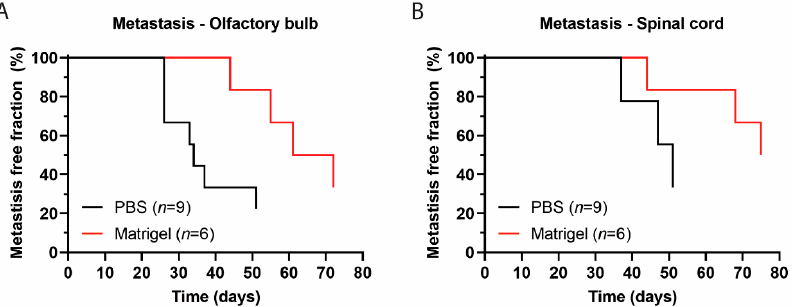
Figure 3. Distant metastatic formations over time monitored through BLI signal following HSJD- DIPG-007 cell inoculation into the pontine region. ( A ) Metastasis in the olfactory bulb in PBS and Matrigel suspension groups with a median onset of 33 and 53 days, respectively. A significant dif- ference between the two groups was found ( p < 0.05). ( B ) Metastasis in the spinal cord in PBS and Matrigel suspension groups with a median onset of 47 and 68 days, respectively, but without a significant difference ( p > 0.05). Mice with cells suspended in PBS showed local growth up to day 31, with subsequent locoregional progression as well as metastatic formations in the mid cerebrum/lateral ven- tricle, with eventual spreading into the cerebellum and olfactory bulb. Mice with cells suspended in Matrigel showed local growth up to day 31 and the presence of tumour cells in the lateral ventricles, with delayed locoregional progression and distal striatal infiltra- tion with inevitable invasion of the whole brain at day 55 (Figure 4). No histopathological or morphological differences were observed in the mice of both groups by H & E staining (Supplementary Figure S3). Antihuman vimentin staining confirmed the local injection of HSJD-DIPG-007 in the pontine region of the mice and showcased that contamination of the cerebrospinal fluid (CSF) and dissemination to other brain structures in proximity to the injection site through the perivascular system (PVS) can occur (Figure 5).